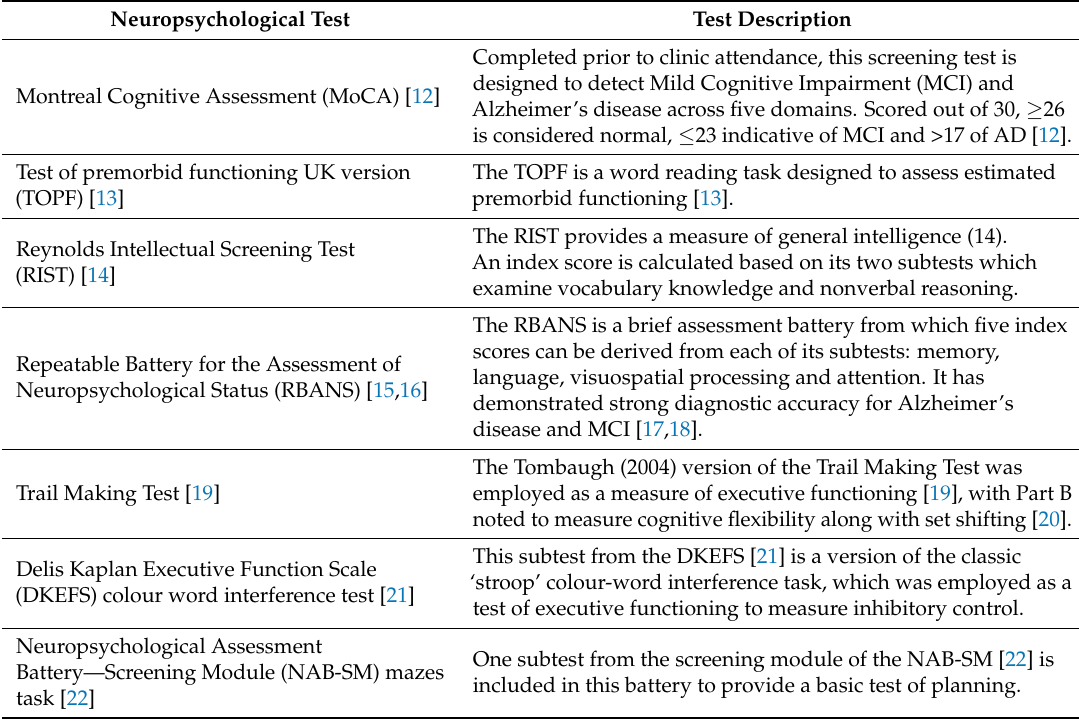
Table 1. Neuropsychological tests used in the Orange